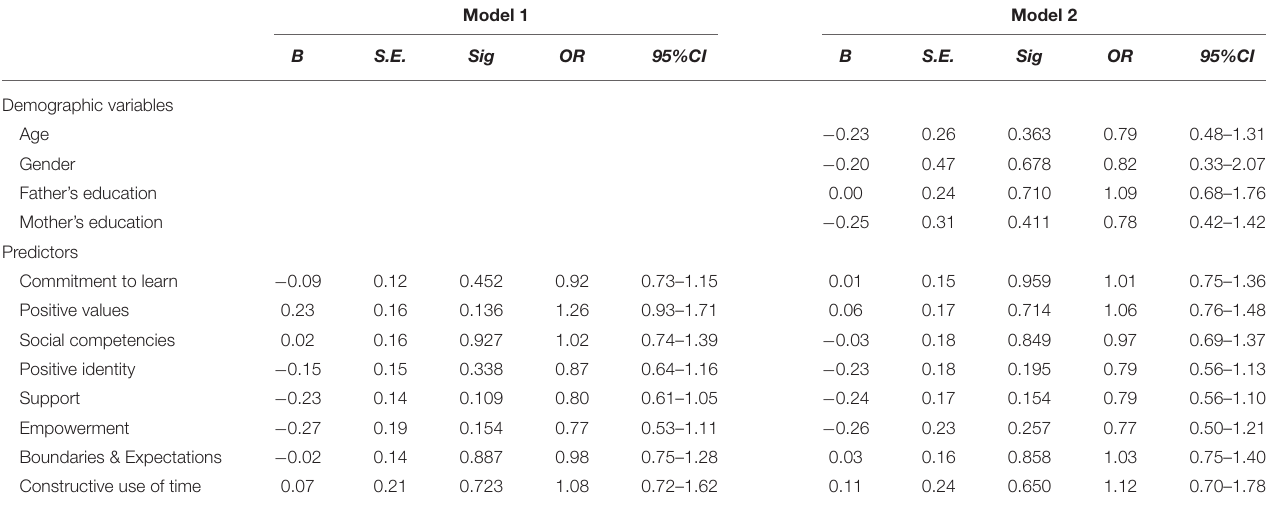
TABLE 4B | Associations between the eight developmental asset categories and suicide attempt: logistic regression analysis.